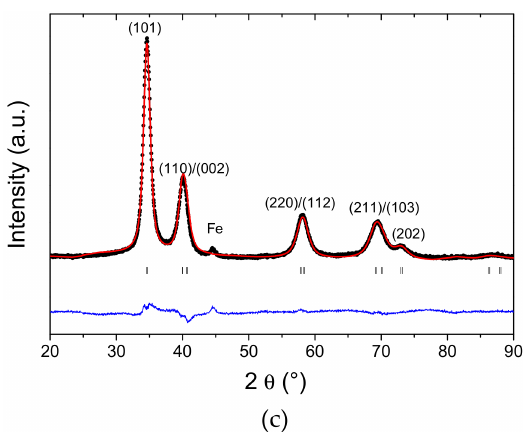
Figure 2. XRD patterns of the Ti 0.325 V 0.275 Zr 0.125 Nb 0.275 alloy prepared by high-temperature arc